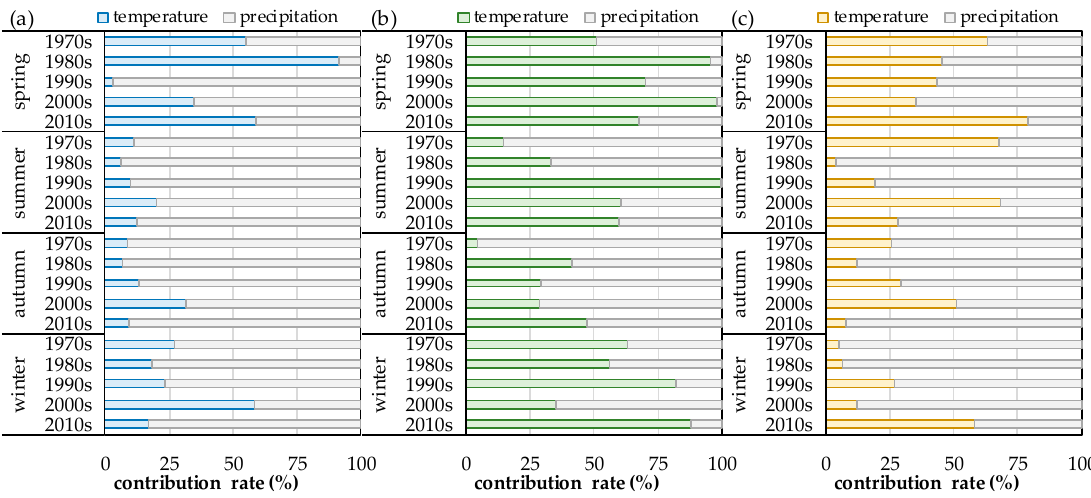
Figure 8. The seasonal contribution rates (%) of temperature and precipitation for hydrological components: ( a ) blue water flow (BWF), ( b ) green water flow (GWF), ( c ) green water storage (GWS).